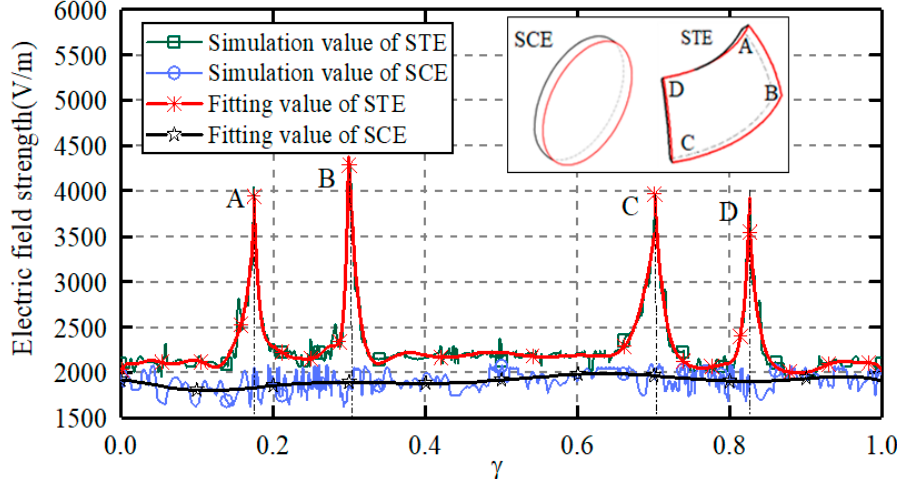
Figure 10. Magnitude distribution of electric field strength along the edge of the capacitive plates.